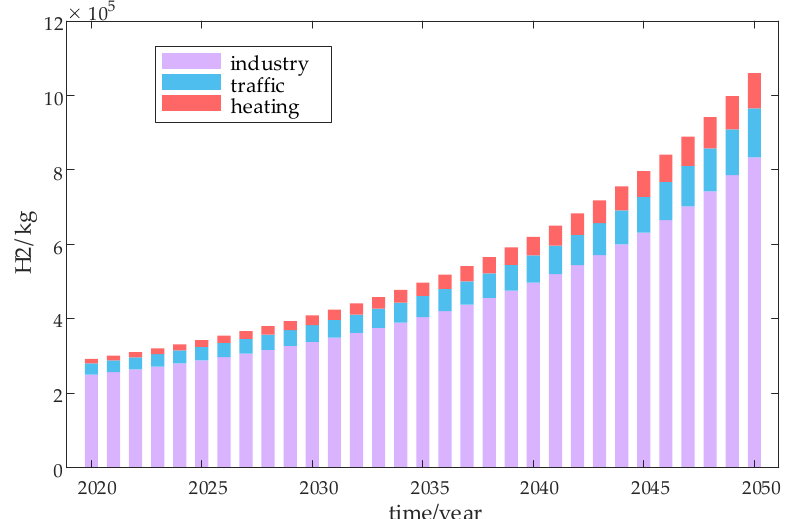
Figure 4. Prediction curve of annual hydrogen load. To reflect the demand balance between electricity and hydrogen, the seasonal and hourly variability of renewable energy sources, and to minimise the difficulty of calcula- tion, one typical day from each of the four seasons of the year was selected for simulation. The hydrogen loads in the transport and municipal heating sectors are more regular, and the industrial hydrogen volumes fluctuate less throughout the year, so the normalised results of the hourly variation of hydrogen loads in each sector are shown in Figure 5.